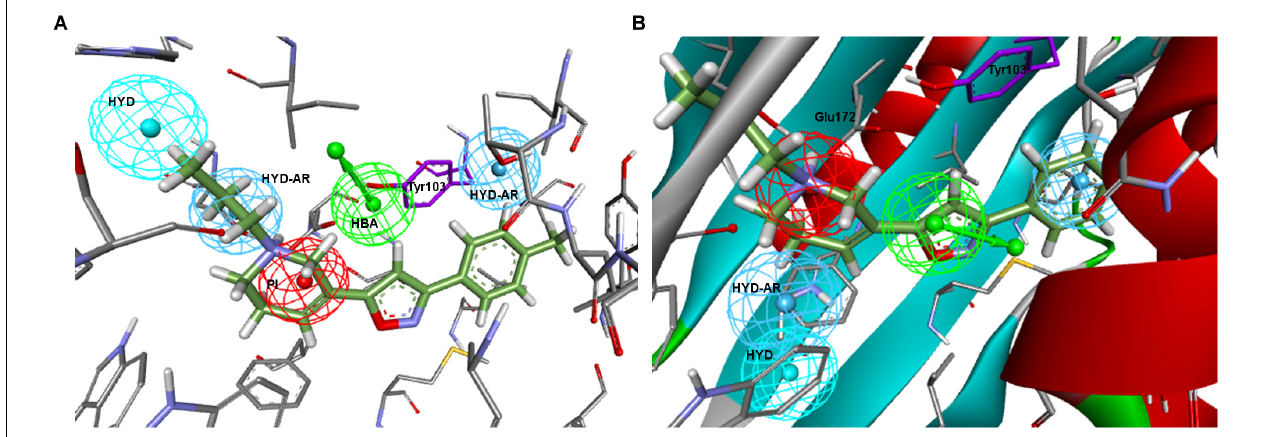
FIGURE 5 | (A) Zampieri–Ph place in the σ 1R binding site resulting from alignment with 5HK1–Ph.A. HBA collapses partially with Tyr103 and the crystallized PD144418 does not fulfill more than 2 features; (B) Placement resulting from the rigid fit of PD144418 to Zampieri–Ph and displacement of the whole set to the crystallographic position of the ligand. Space constrains can be observed for the non-fitted HYD and HYD-AR features.